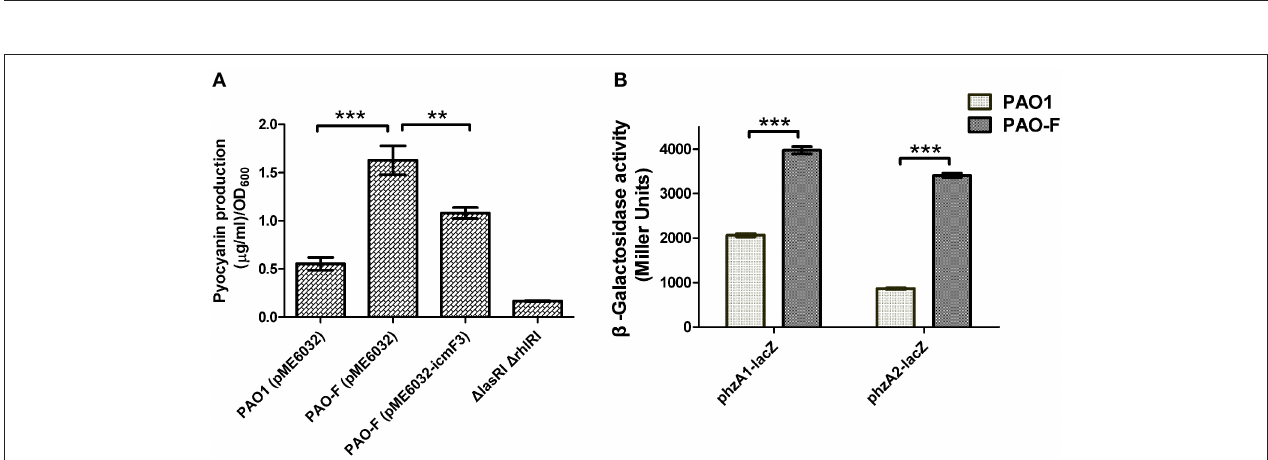
FIGURE 8 | Pyocyanin production by P. aeruginosa WT and icmF3 mutant. Cells were grown in TSB broth to an OD 600 of 4.0 at 37 ◦ C with aeration. (A) Spectrophotometric quantitation of pyocyanin production in P. aeruginosa cultures. Extraction procedures are outlined in Materials and methods. The 1 lasRI 1 rhlRI strain was used as a negative control. (B) Levels of phzA1B1C1D1E1F1G1 and phzA2B2C2D2E2F2G2 transcription in P. aeruginosa WT and the icmF3 mutant were monitored using the phzA1–lacZ and phzA2–lacZ transcriptional fusions, respectively. If needed, 1mM IPTG was included in the medium for induction. The graphs show the mean and SD of two experiments performed in eight replicates each time. ** P < 0.01 , *** P < 0.001 .